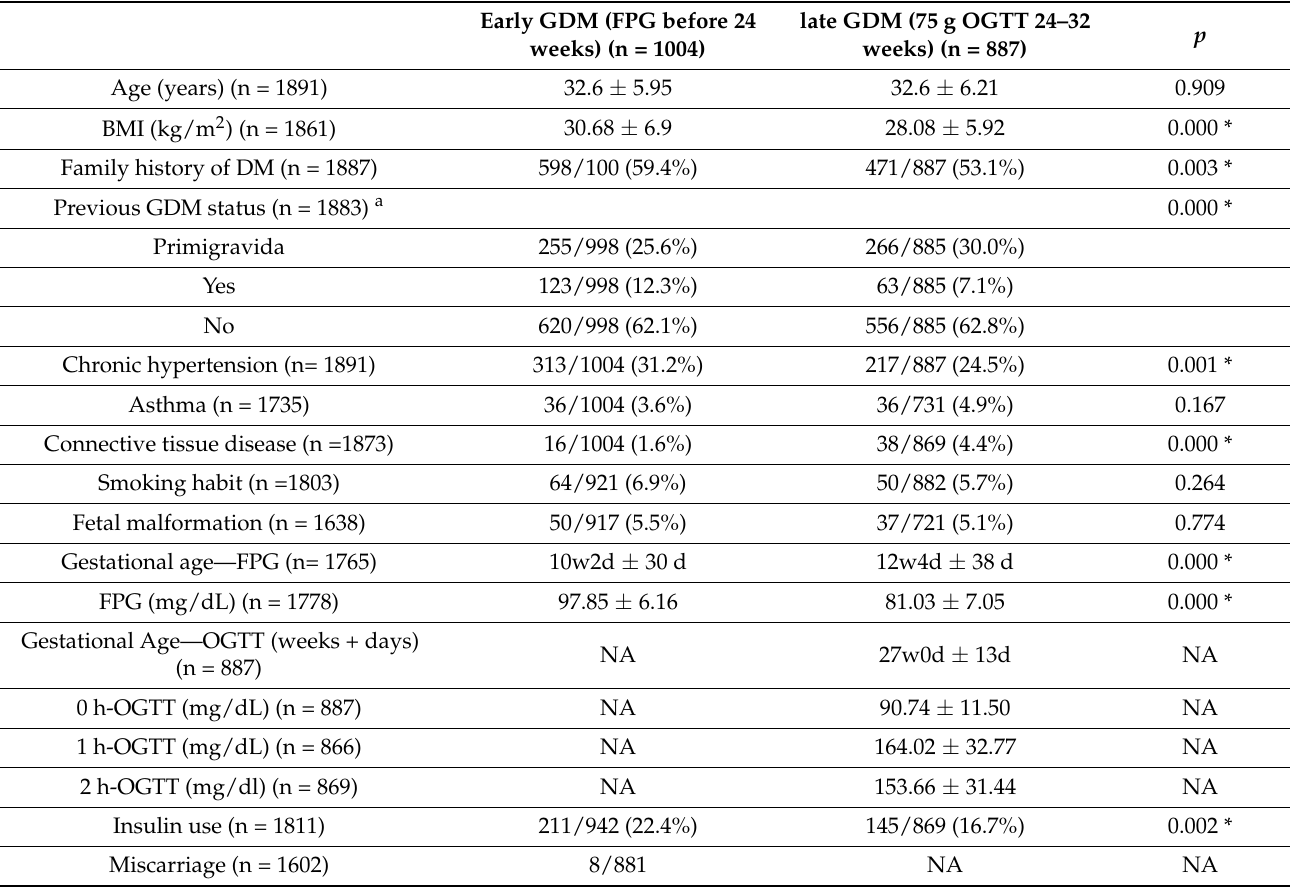
Table 1. Baseline characteristics of women diagnosed with early or late gestational